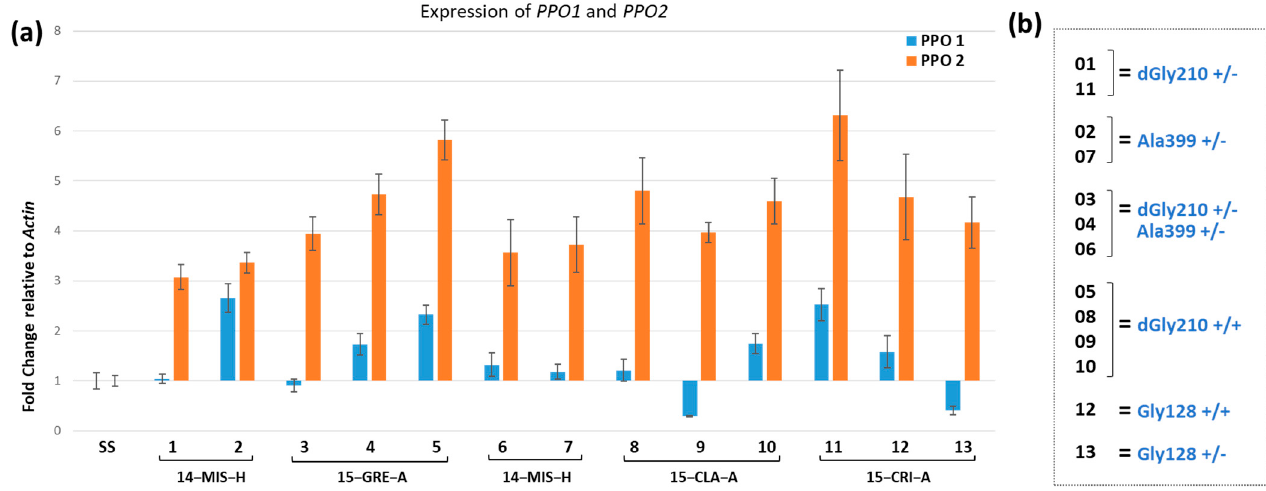
Figure 1. Expression analysis of PPO1 and PPO2 gene in A. palmeri seedlings ( a ) nontreated (SS, 1 and 2) and treated (3, 4, 5, 6, 7, 8, 9, 10, 11, 12, and 13) with soil-application with 2x fomesafen. Each bar represents the relative expression (fold change) of each gene in nontreated and treated seedlings compared to nontreated SS plants. Data are means ± SE of three biological replicates (except nontreated from 14-MIS-H). Expression of PPO1 and PPO2 were normalized against Actin . ( b ) Genotyping of each sample used in expression analysis.